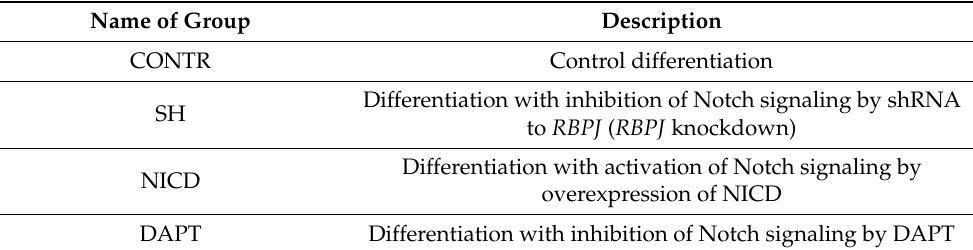
Table 1. Description of experimental